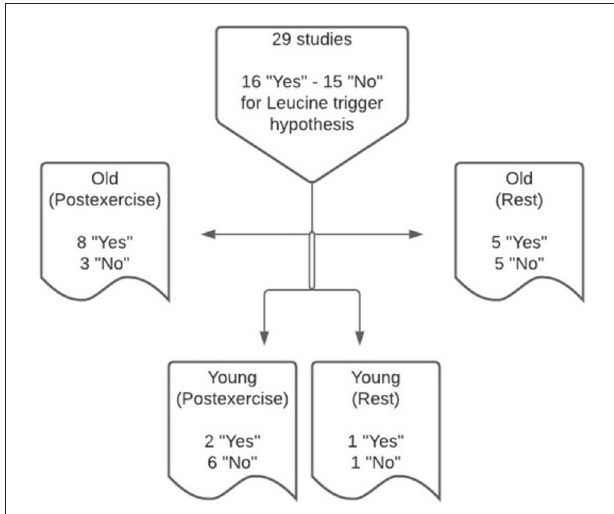
FIGURE 2 | Synthesis of findings from 29 studies that support or refute the leucine trigger hypothesis to explain the post-prandial regulation of muscle protein synthesis in young and older adults at rest and following exercise, using 31 study arms